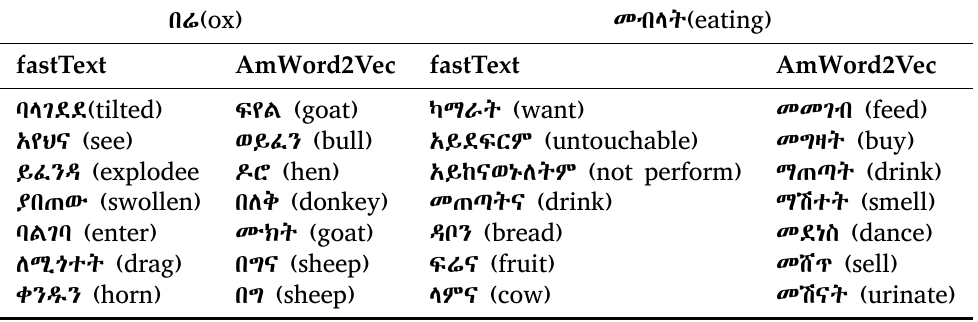
Table 3. Comparison of word similarities computed using the pre‑trained fastText and the